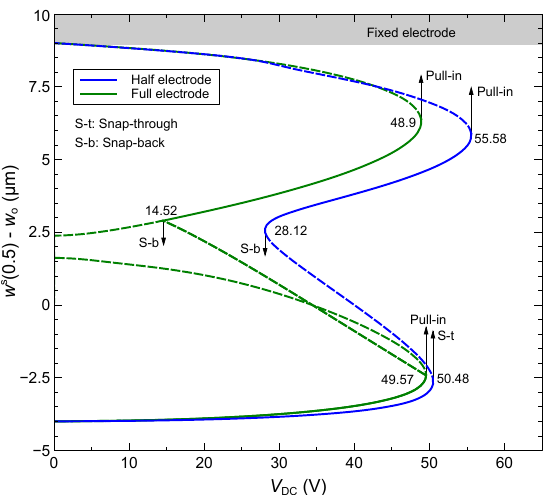
Figure 7. Static response at the midpoint of the arched microbeam: full vs. half-electrode actuation. The initial rise is set to w o = 4 µ m.